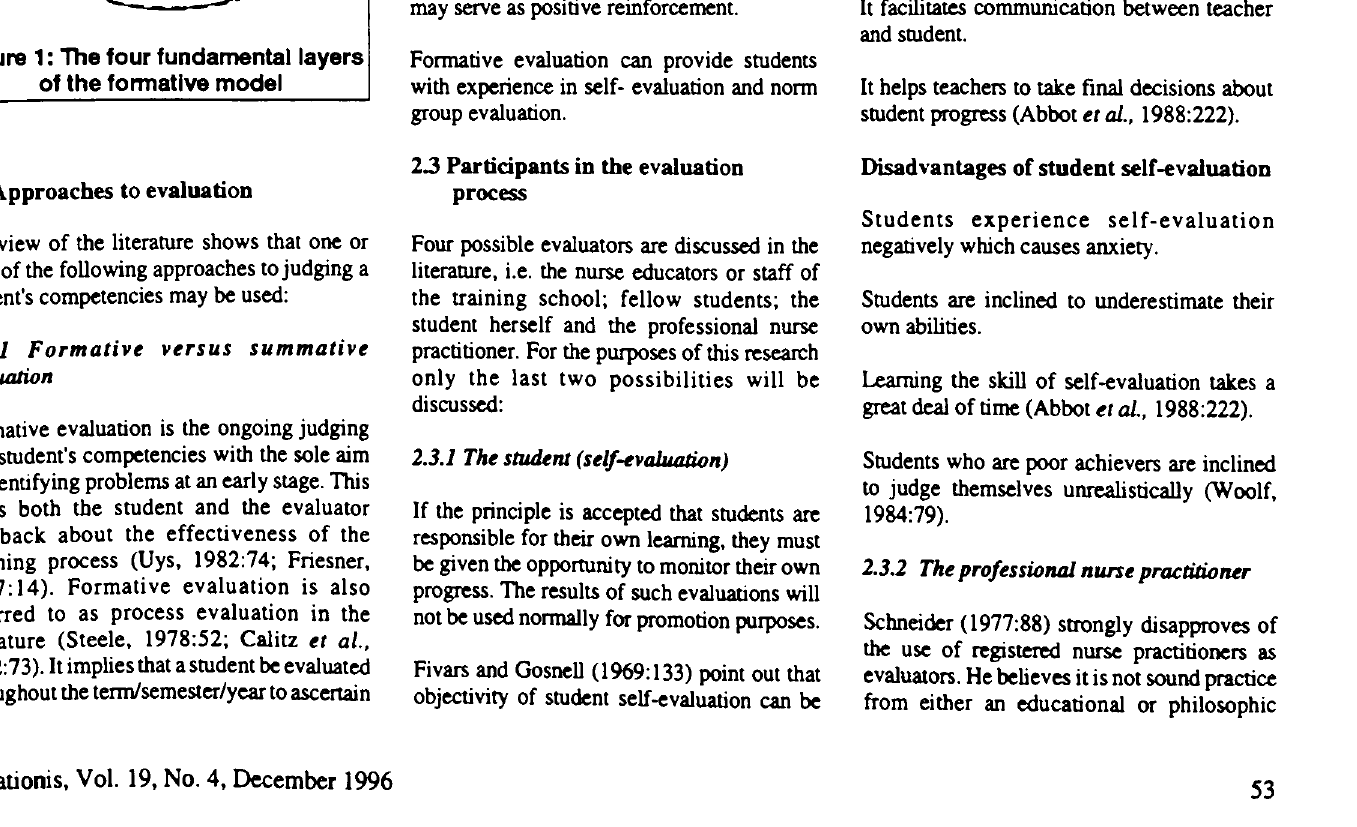
Figure 1: The four fundamental layers of the formative